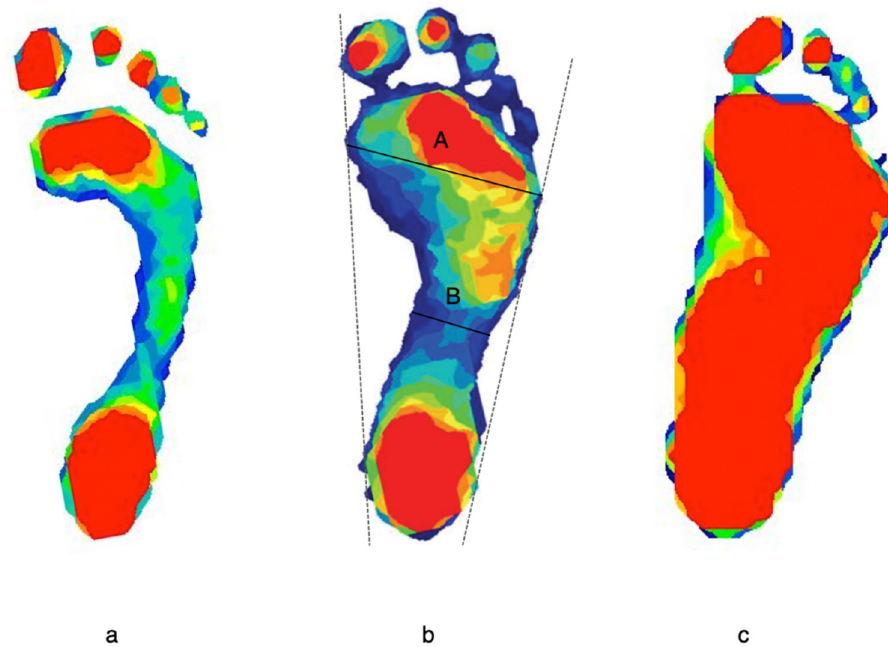
Fig 1. Example of digital foot pressure data. These feet represent three participants: one with a higher arch (a), one with a normal arch (b), and one with a lower arch (c). The colors indicate areas of the feet that exert pressure that is graded from low (blue) to high (red) areas of pressure in kilopascals. The high-arched individual on the left (a) is a 31-year-old male with a BMI of 22.06 kg/ m 2 . The low-arched individual on the right (c) is male, 28 years old, and has a BMI of 64.14 kg/ m 2 . The Chippaux-Smirak Index equals the ratio of the smallest distance of the midfoot (B) and the longest distance of the forefoot (A) as described in Fig 1(B).